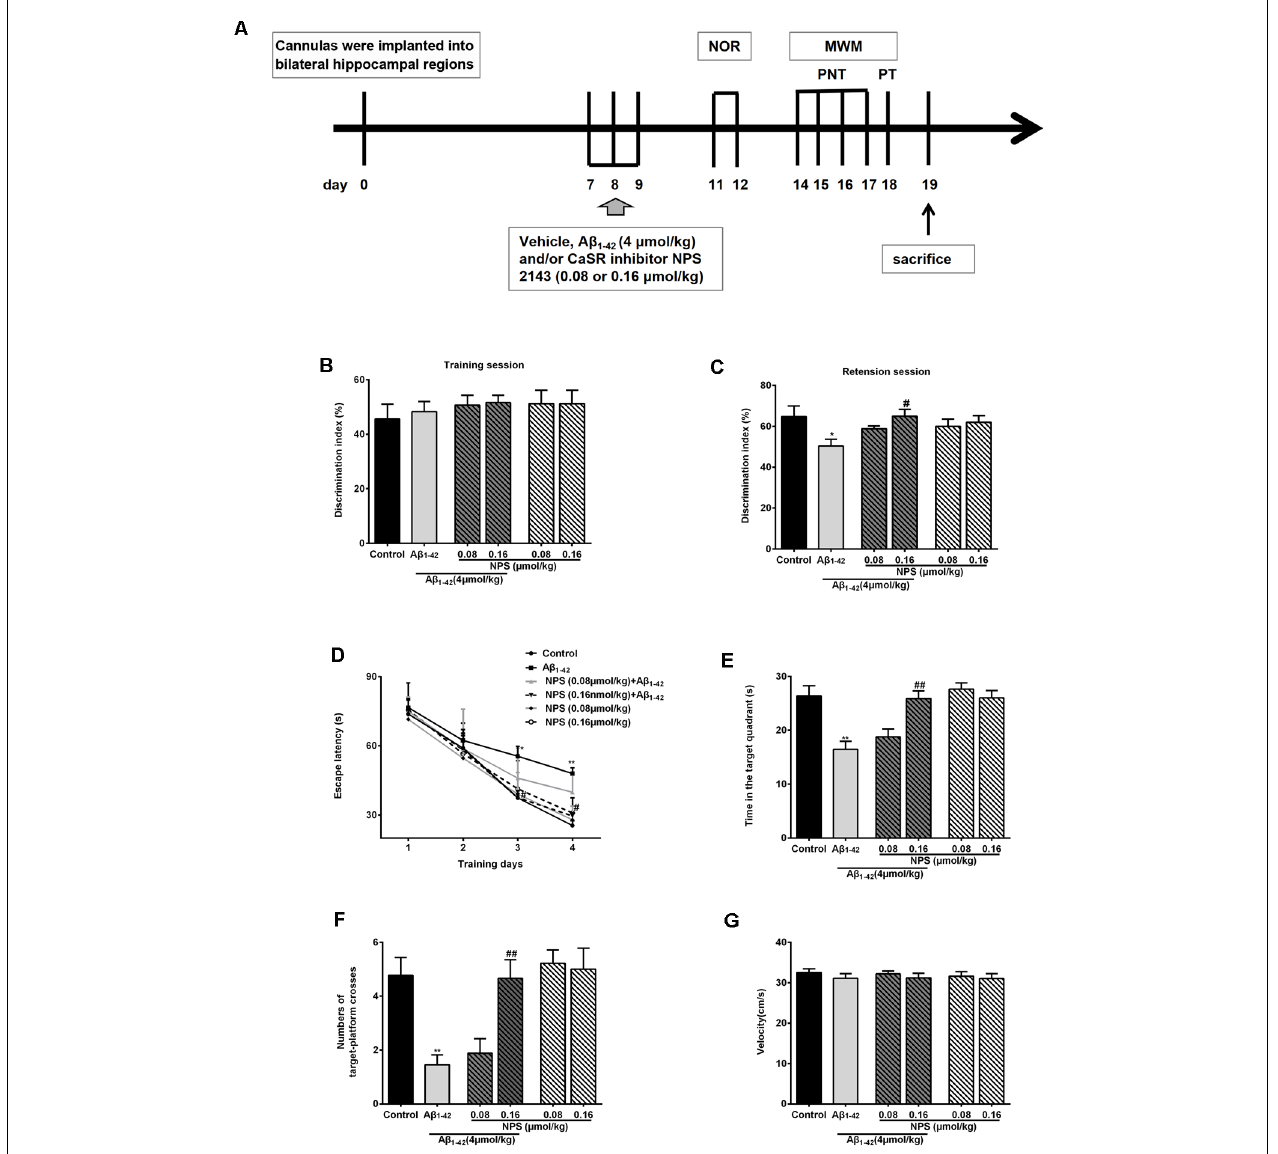
FIGURE 7 | Protective function of inhibiting CaSR on oligomeric A β 1–42 -induced recognitive and spatial learning deficits. (A) Experimental schedule of behavioral tests. Cannulas were implanted into bilateral hippocampal regions. Vehicle, A β 1–42 (4 µ mol/kg) and/or CaSR inhibitor NPS 2143 (0.08 or 0.16 µ mol/kg body weight per day) were microinjected for 3 days from day 7 to 9. From day 11 to day 12, the novel object recognition (NOR) tests were performed. Morris water maze (MWM) tests were conducted from day 14 to 18 day. Place navigation tests (PNT) of the MWM were conducted four times a day for four consecutive days, followed by a probe trial test (PT) 24 h after the last PNT. The mice were sacrificed after behavioral experiments. (B) Discrimination indexes displayed no significant difference among these groups in the training session. (C) Quantitative comparison of the discrimination indexes in the retention session, n = 8 animals for each group. (D) The escape latency of the control, the oligomeric A β 1–42 -treated group (4 µ mol/kg), and/or the NPS 2143-treated group (0.08 or 0.16 µ mol/kg) during the four training days. (E) Quantitative comparison of the time in the target quadrant of the six groups. (F) Quantitative comparison of the number of target platform crosses of the six groups. (G) Swimming speed of the six groups did not show significant different. * P < 0.05 vs. control group, ** P < 0.01 vs. control group, # P < 0.05 vs. A β 1–42 oligomer-treated group, ## P < 0.01 vs. A β 1–42 oligomer-treated group. Values represent mean ± SEM, n = 8 animals for each